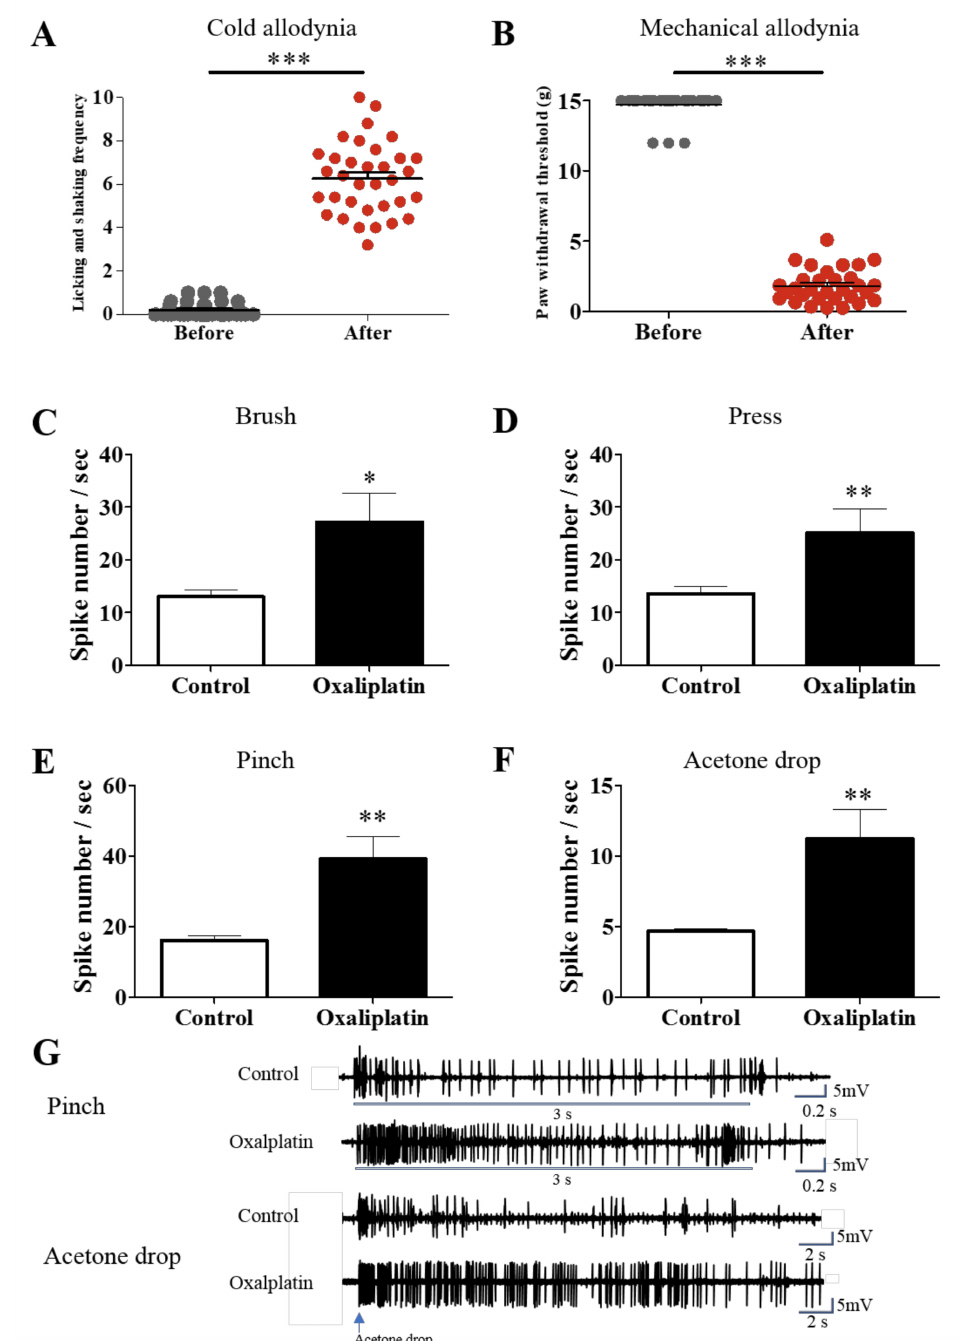
Figure 1. Single oxaliplatin injection induces neuropathic pain behaviors and hyperexcitation of spinal neurons in rats. Four days after single oxaliplatin injection, significant cold; n = 34 ( A ) and mechanical; n = 31 ( B ) allodynia were induced in rats. Firing frequencies of spinal dorsal horn WDR cells to brush, press, pinch and acetone drop stimuli were measured after 5% glucose (control, n = 7) or oxaliplatin (oxaliplatin, n = 7) injections ( C–F ). Representative raw trace of WDR neuron firings to pinch and acetone drop stimuli in the control and oxaliplatin groups ( G ). Data is presented as the mean ± S.E.M.; * p < 0.05, ** p < 0.01, *** p < 0.001 vs. Before; by paired t -test ( A , B ) and * p < 0.05, ** p < 0.01, *** p < 0.001 vs. Control; by unpaired t -test (C–F)